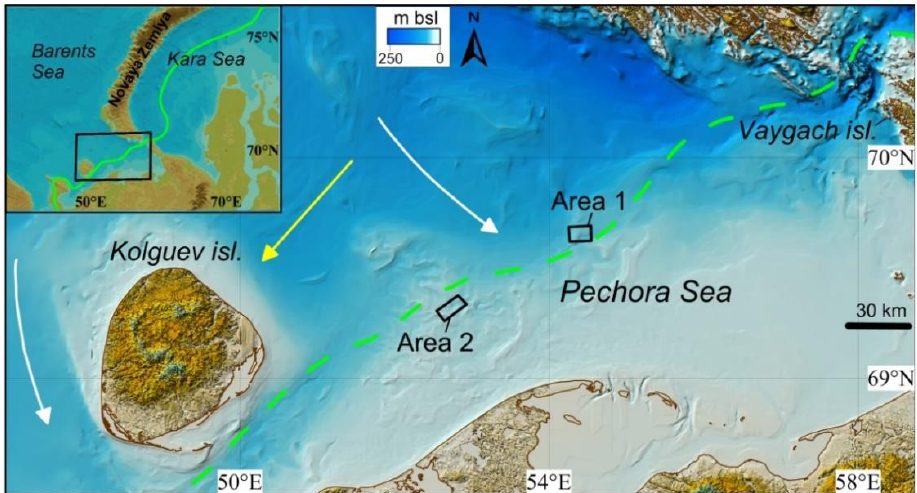
Figure 1. Overview map of the working area and polygons of detailed research. The green line shows the supposed margin of the Late Weichselian glaciation (after [14]). Large-scale ice-flow directions (white arrows) during the LGM are indicated [9,17]. The yellow arrow shows the ice sheet flow during the LGM, inferred from the composition of glacial erratics in diamictons [7]. Bathymetry retrieved from [18].